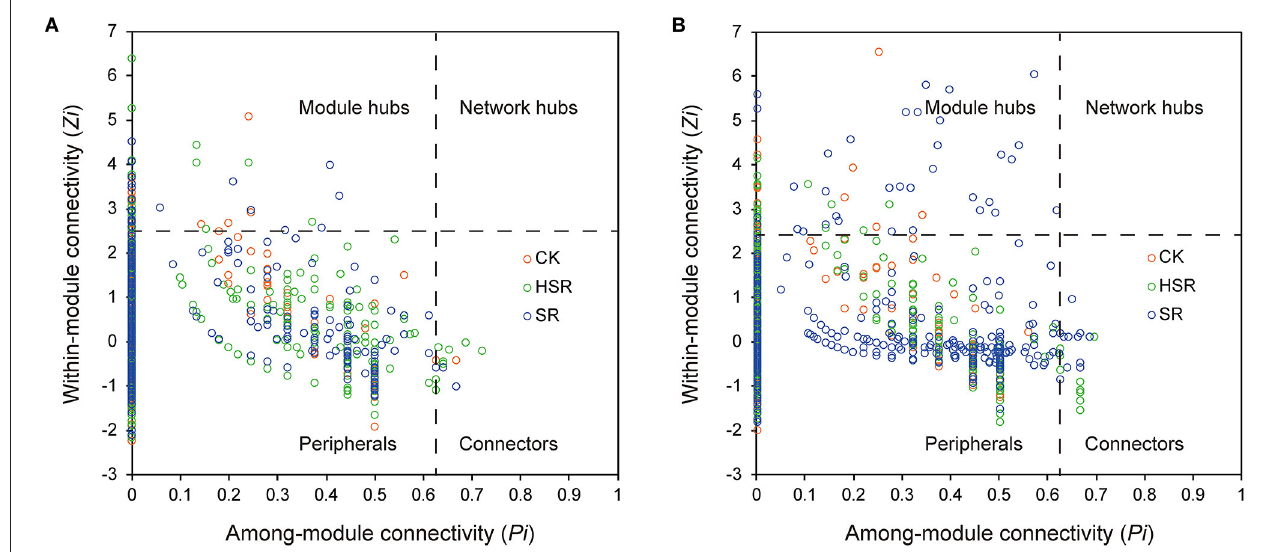
FIGURE 7 | Distribution map of soil bacteria Zi-Pi based on topology. Zi > 2.5 and/or Pi > 0.625 are defined as Keystone OUT. (A) Distribution map of soil bacteria Zi-Pi in the wheat season. (B) Distribution map of soil bacteria Zi-Pi in the wheat